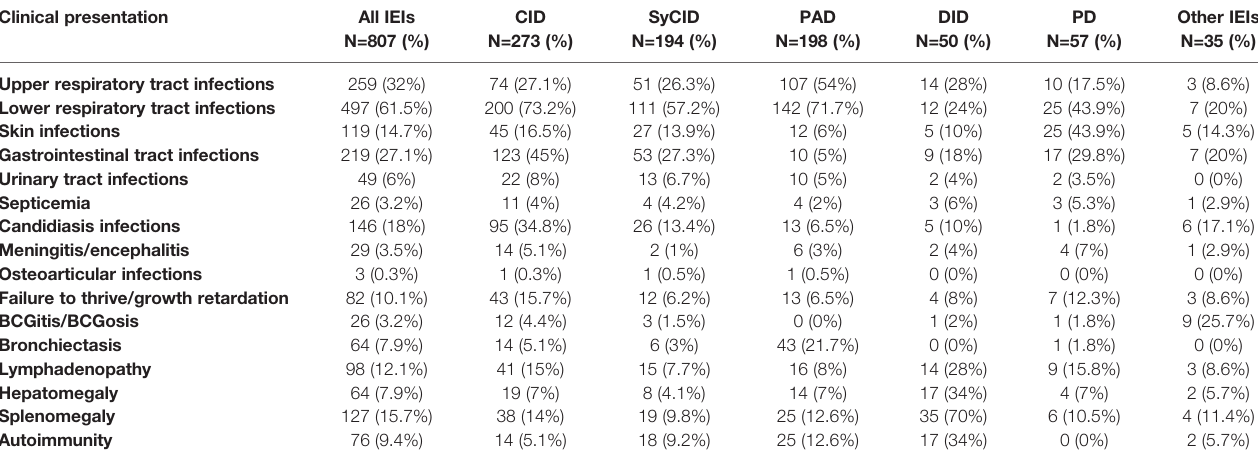
TABLE 2 | Clinical presentations and complications of IEIs observed in Algerian patients. Clinical